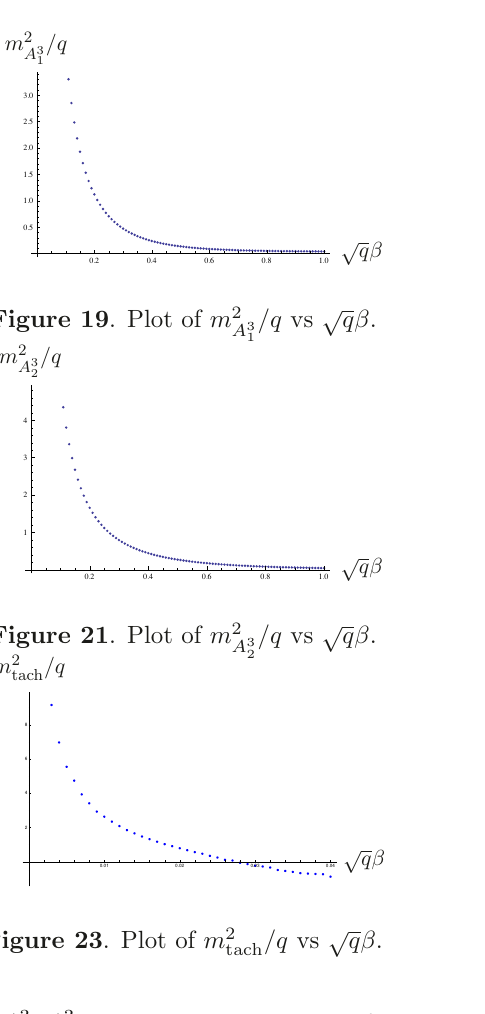
Figure 19 . Plot of m 2